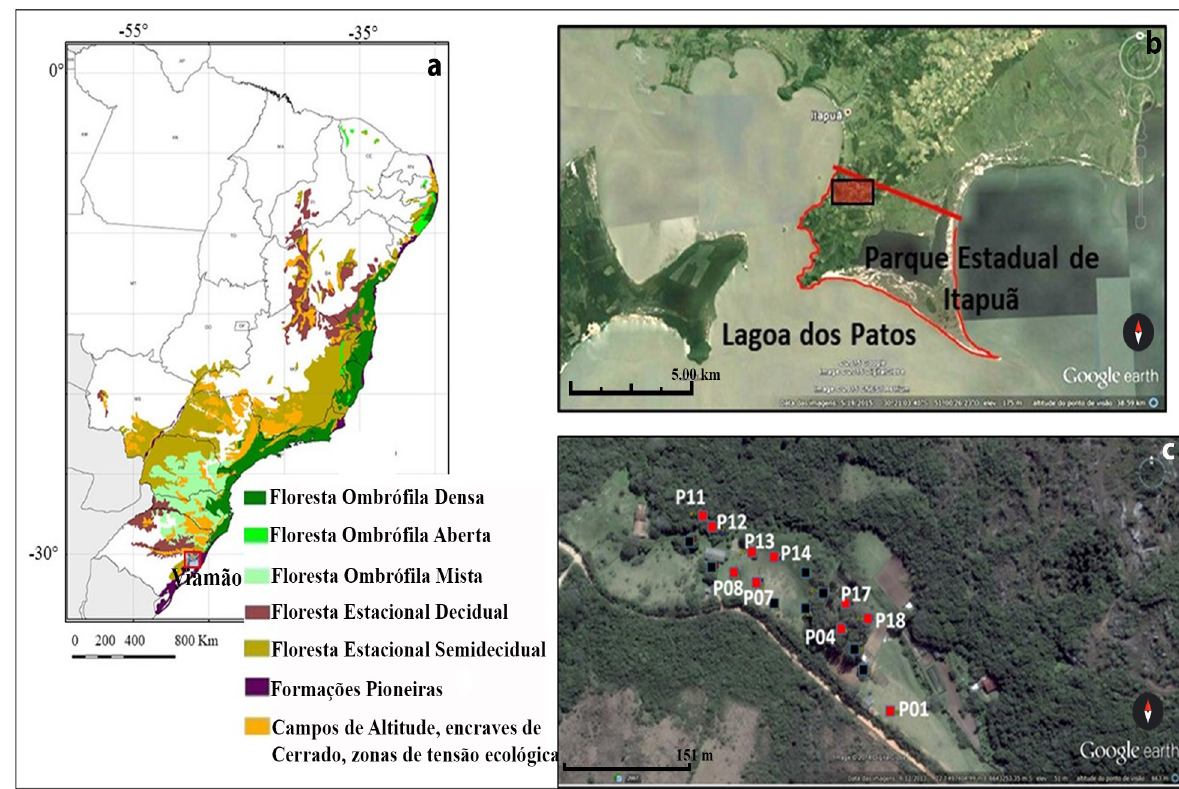
Figure 1. (a) Location of the study area: territorial insertion and vegetal physiognomies of Brazil (Source FIBGE 1993); (b) Collection area in the Itapuã State Park and ( c) Inserted traps with GPS coordinates, taken during the field work. Points analyzed highlighted in red. Source of images: Google Earth